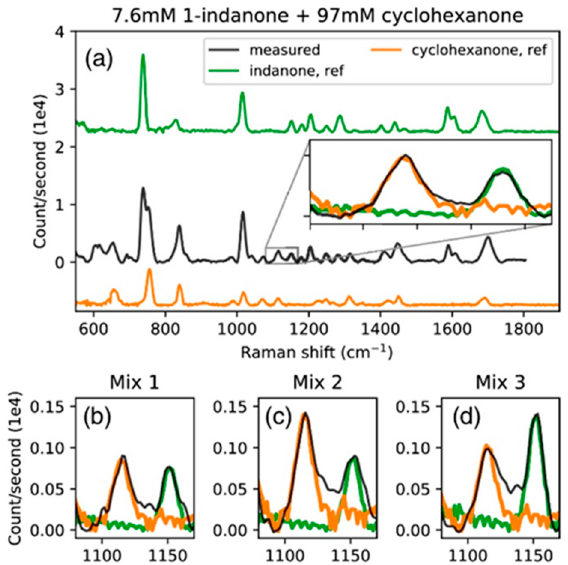
Figure 6. (Reprinted with permission from [55] © Optica) Background-subtracted spectrum of ( a ) 7.6 mM (1 g/L) 1-indanone and 97 mM (1%) cyclohexanone solution, ( b ) 1.9 mM (0.25 g/L) 1-indanone and 24 mM (0.25%) cyclohexanone, ( c ) 1.9 mM 1-indanone and 48 mM (0.5%) cyclohexanone, and ( d ) 3.8 mM (0.5 g/L) 1-indanone and 24 mM cyclohexanone. Ta 2 O 5 also may be combined with glass to make composite optical waveguides.